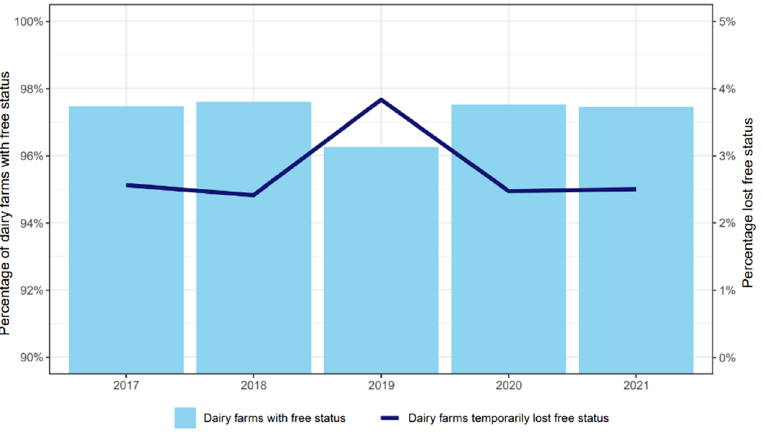
Figure 3. Percentages of dairy herds participating in the Leptospira Hardjo Control Programme with the free status (light blue columns) and the percentage that temporarily lost the status from 2017 to 2021 (dark blue line).